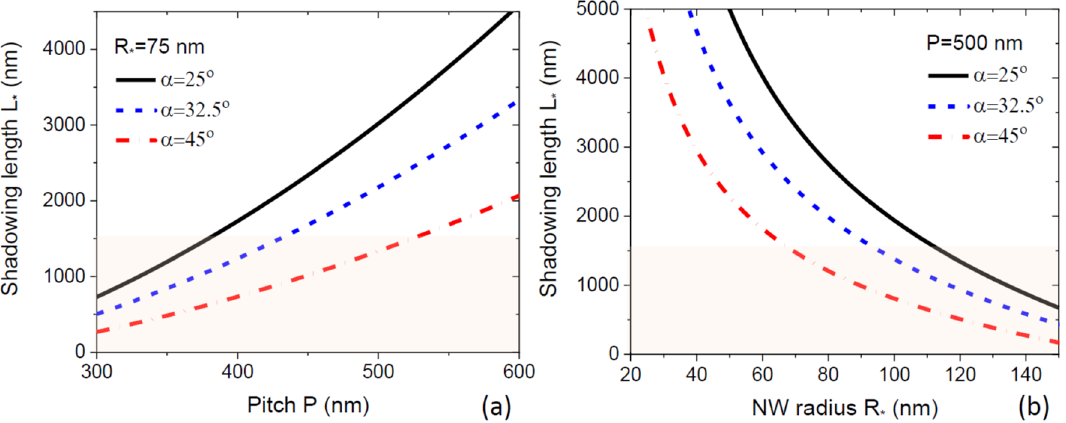
Figure 3. Shadowing length versus ( a ) the array pitch at a fixed NW radius of 75 nm and ( b ) NW radius at a fixed pitch of 500 nm for three different beam angles shown in the legend. Shadowing length increases with the pitch and decreases with the radius and the beam angle. The colored zones correspond to the absence of radial growth ( R ∗ = R 0 ) for GaAs NWs at a diffusion length of Ga adatoms of 1500 nm.